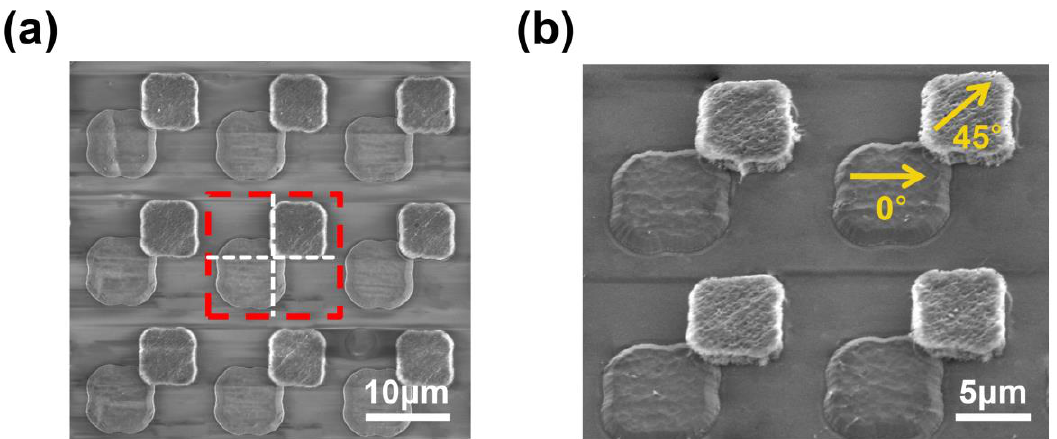
Figure 3. ( a ) Top view of the fabricated dual-tier MPA under SEM and the 2 × 2 unit is framed with red lines, and the two pixels are distinguished by a white cross. ( b ) The magnified SEM image of ( a ) and tilted by 30 degrees shows the height contrast and CNT orientation difference between the squares in the two layers.